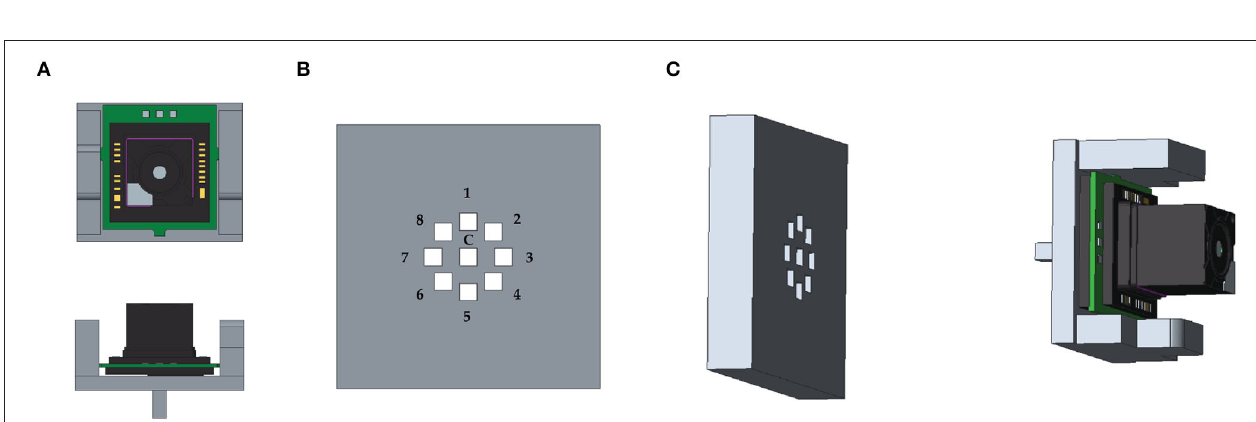
FIGURE 7 | (A) 3D CAD of the mounting template used for placing the viewpoint camera in the calibration position (c) and in the eight different viewpoint positions within the eye-box of the see-through display. (B) The nine fixing holes for camera positioning. (C) The mounting